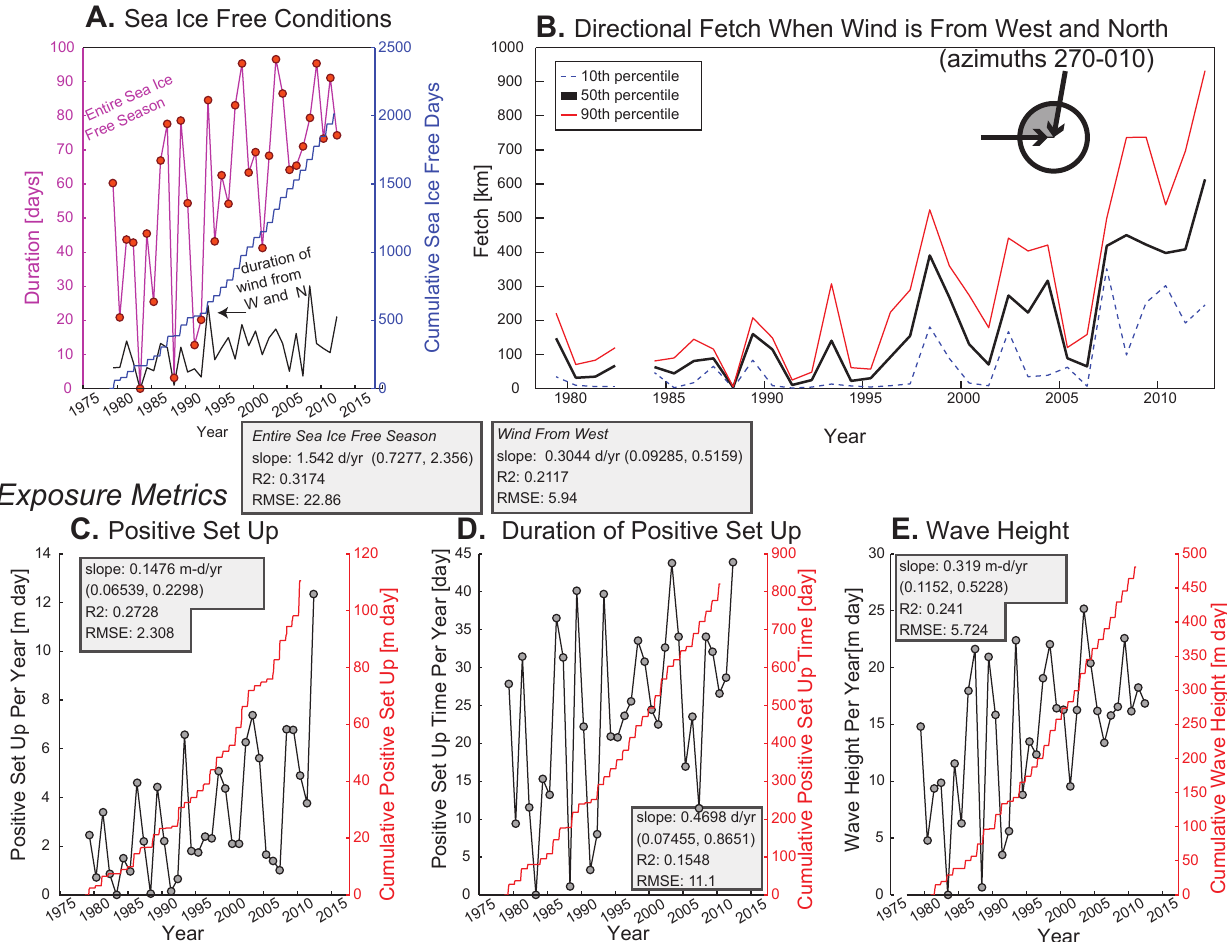
Figure 12. Environmental conditions (top row), exposure metrics (middle row), and normalized exposure metrics (bottom row) calculated at Drew Point over the period 1979–2012. In (a) and (c) – (e) , we show both the value for the yearly metric (left-hand axis) and the cumulative value (right-hand axis). The duration of the open-water season and the duration of winds from the west both show a significant increase over this time period (a) . The slope of a linear trend line (with 95% confidence bounds in parentheses), the R 2 , and RMSE are given for each yearly metric in the boxes, gray indicates significant at 95% level and white indicates not significant. The distance to the sea-ice edge (directional fetch) when the wind is from the west has increased (b) . The three exposure metrics – positive setup (c) , duration of positive setup (d) , and wave height (e) – all show large inter-annual variability and all have significant positive linear trends.